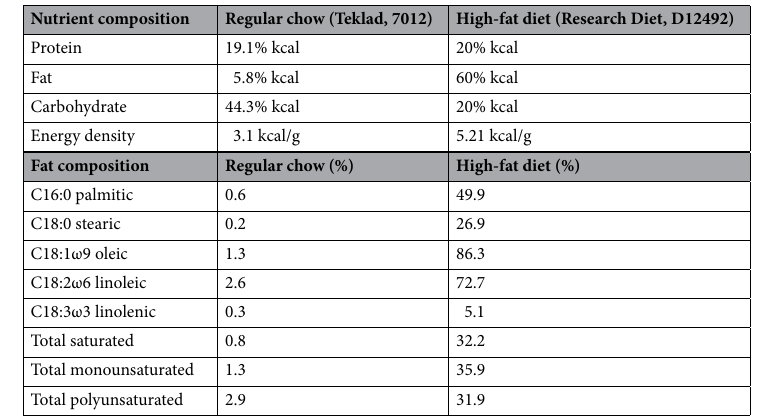
Table 1. Diet composition. The table shows the differences in nutrient composition between the regular diet and the HFD, with a focus on the fat composition for each